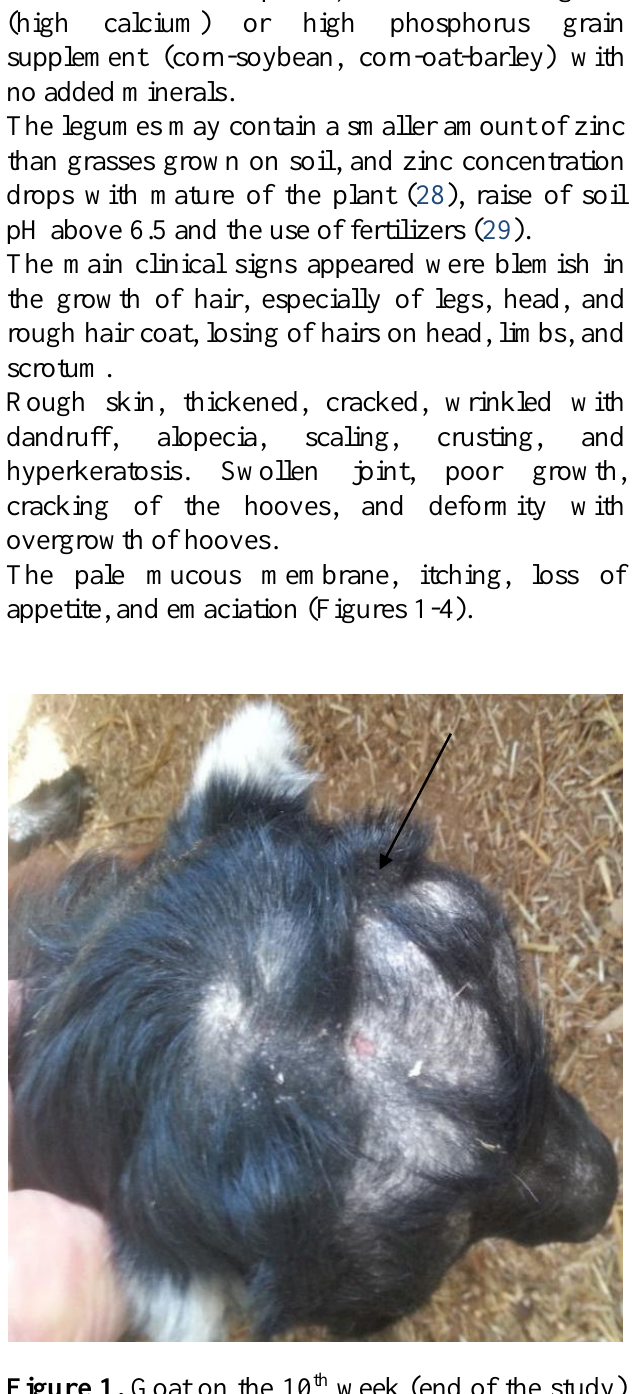
study) with rough and hair loss on